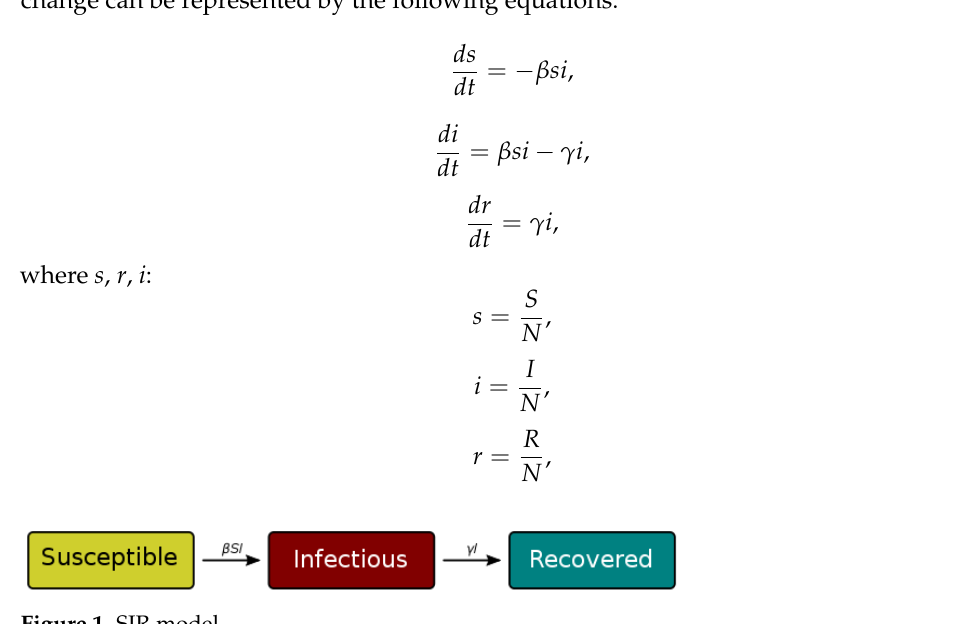
Figure 1. SIR model.